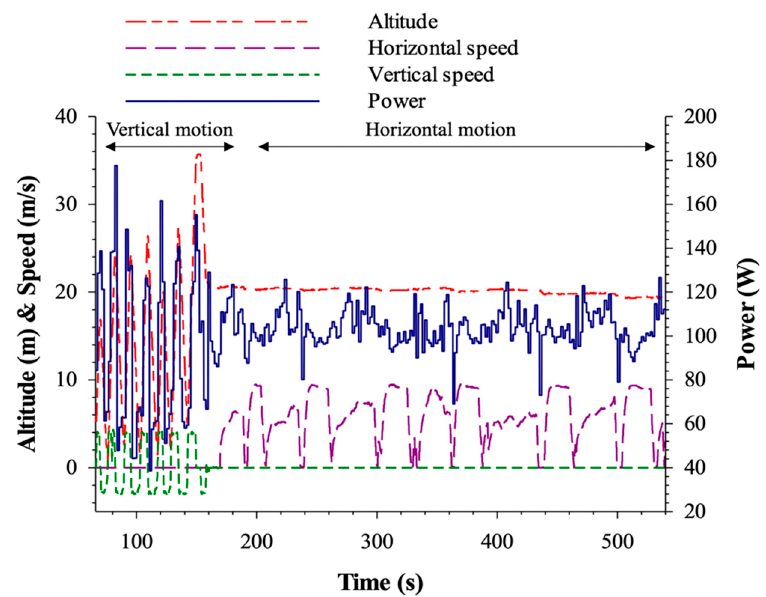
ff erent motions.